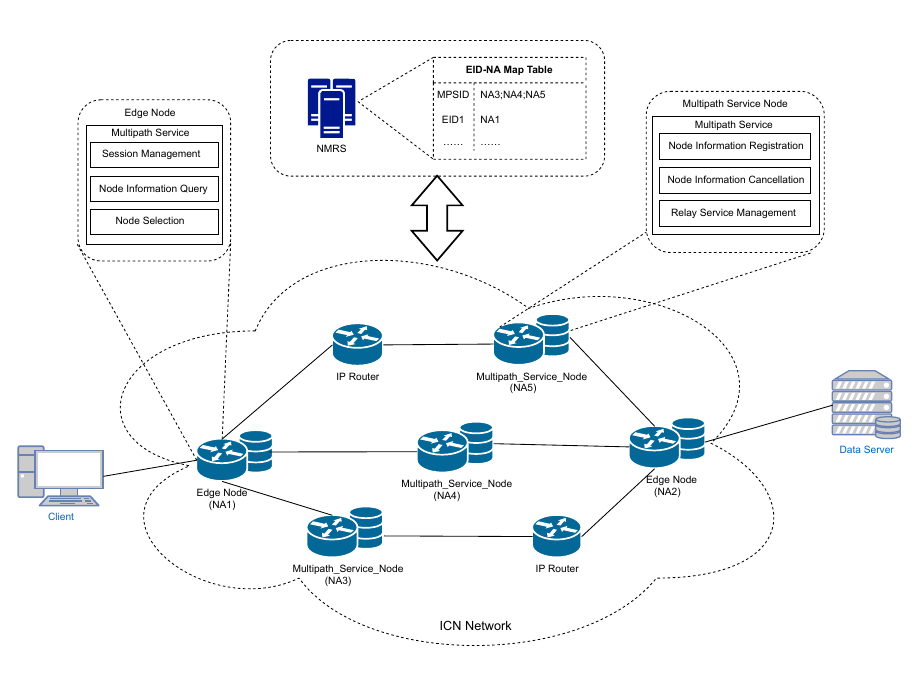
Figure 1. The structure of the multipath transmission system for ICN based on standalone name